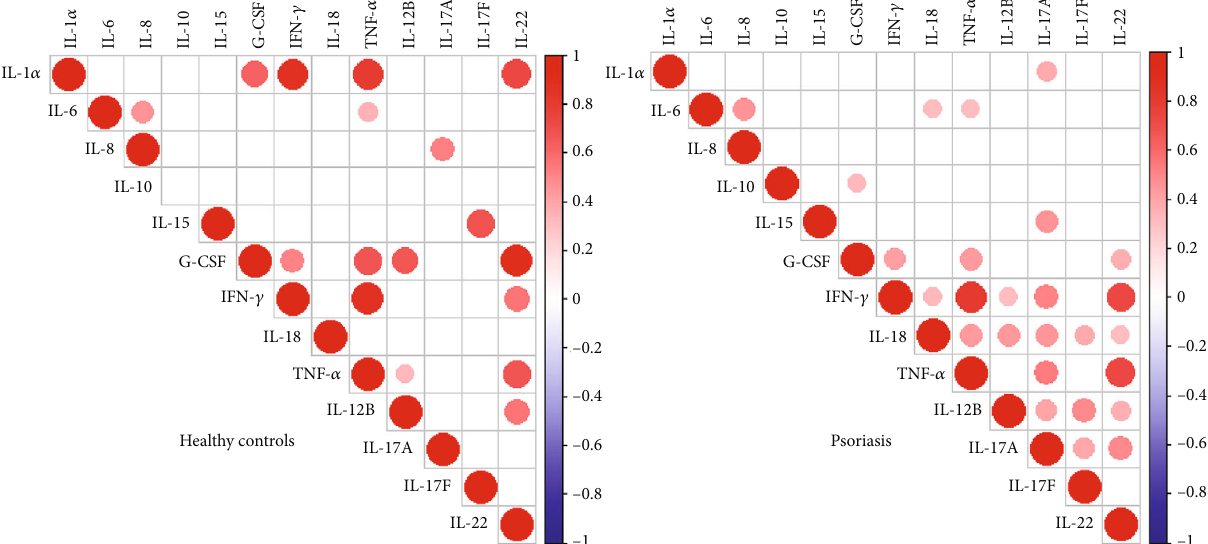
Figure 3: Correlation of serum cytokines in healthy controls (HC) and psoriasis patients (PSO). Correlations of cytokines in (a) HC ( n = 40 ) and (b) PSO ( n = 44 ) are analyzed by Spearman ’ s correlation. Positive correlations are shown as red and negative as blue. The intensity of color and the size of dots are proportional to the correlation coe ffi cients. Only signi fi cant Spearman ’ s correlation coe ffi cients ( p < 0 : 05 ) are